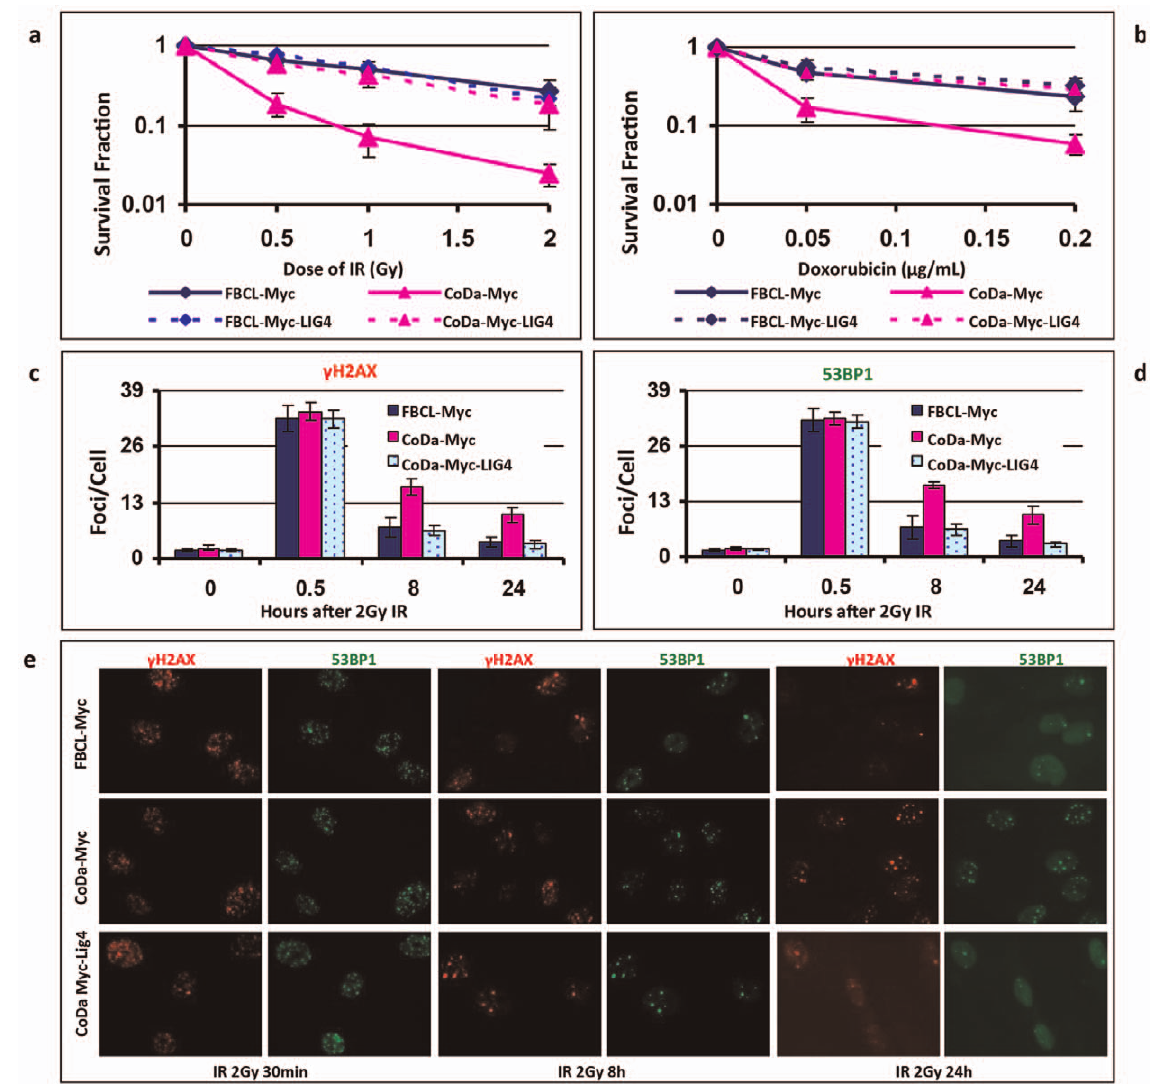
Figure 9. Expression of wild type LIG4 complements the cellular sensitivity of CoDa cells to DNA damage agents and rescues DSB repair defect. CoDa and FBCL cells were infected with retrovirus that express Myc-LIG4 or Myc (negative control) and selected with puromycin for 1 week. The cells were used for cellular sensitivity analysis or fluorescent immunostaining. Panel (a) shows the survival curve with irradiation treatment measured with colony formation assay. Panel (b) shows the cellular sensitivity to doxorubicin treatment assessed by growth inhibition assay (see Materilas and Method for details). For immunostaining, the cells grown on coverglass were fixed at various time points after 2 Gy IR and co-stained with anti- c H2AX (Red) and anti-53BP1 (Green) antibodies. DAPI staining (Blue) shows the location of nuclear. The numbers of c H2AX and 53BP1 foci were counted in at least 200 cells from each slide and the experiments were repeated twice. Shown are the averages nuclear focus numbers of c H2AX (Panel c) and 53BP1 (Panel d). Error bars were the standard deviations. Panel e is representative images taken at 30 min, 8 hour and 24 hours after 2 Gy irradiation.